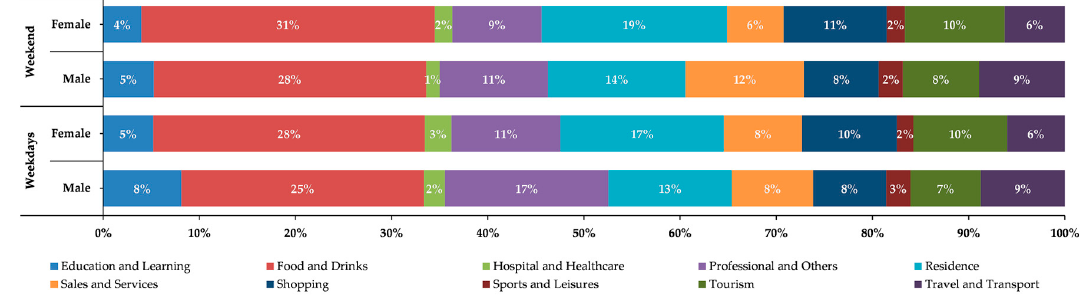
Figure 5. Sex-based distribution of activities during weekdays and weekend.